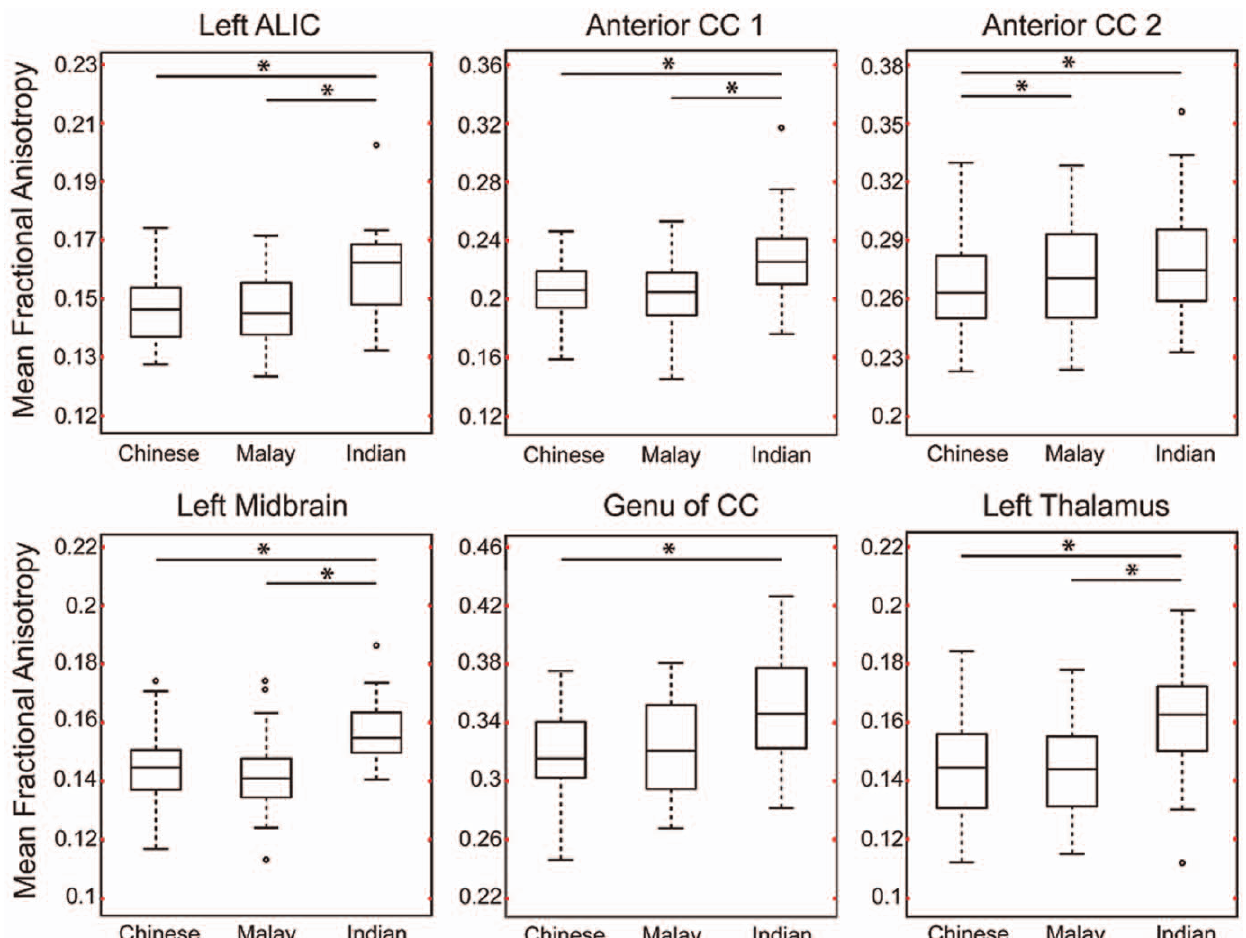
Figure 4. Boxplots of mean fractional anisotropy (FA) within the anatomical regions extracted from voxel-based analysis on FA (see Figure 2B). The significant pairwise group difference is indicated using black asterisk.